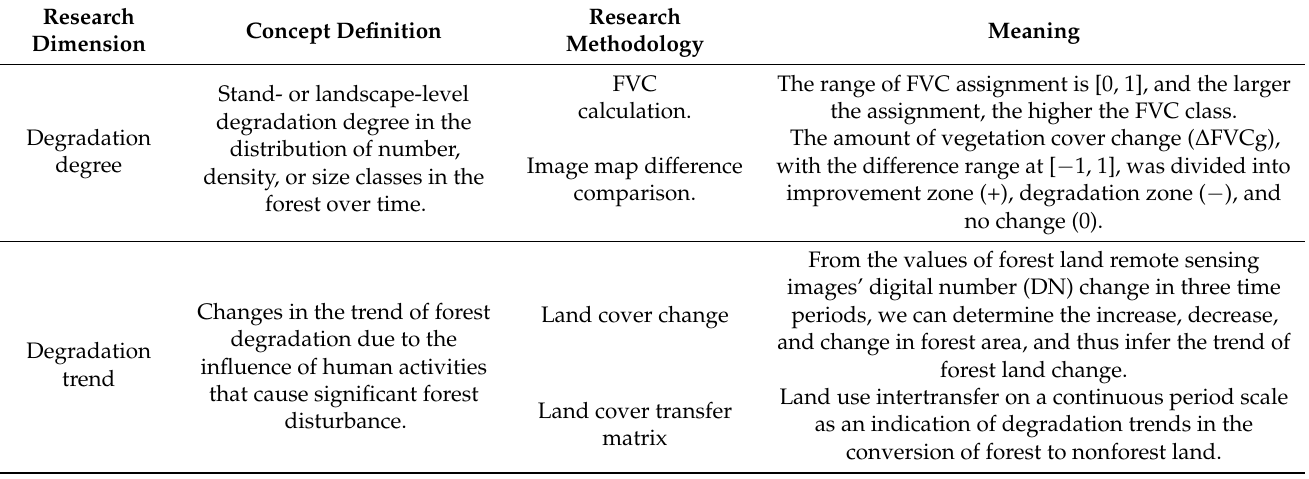
Table 1. List of research methods for DTP degradation assessment